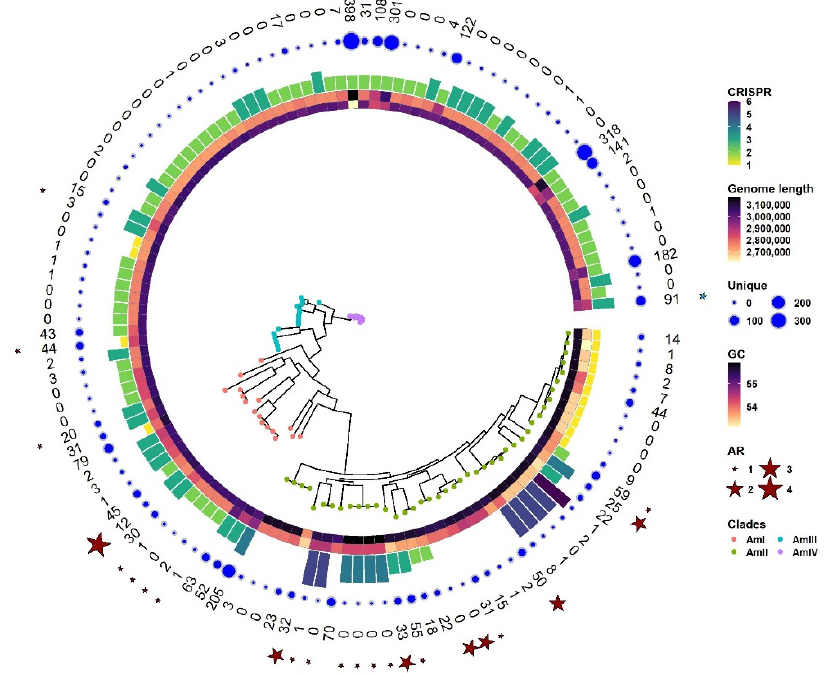
Figure 7. Phylogenetic tree of A. muciniphila strains. Information around the tree provides an overview of the genetic potential of different strains predicted using suitable tools. Strains from different phylogroups are colored differently. The clustering of the strains in the phylogenetic tree corresponds to the clustering inferred in Section 3.4. Layers around the tree denote (from inside out) GC content, genome length, number of CRISPR sequences, number of unique genes as a bubble, number of unique genes in digits, antibiotic resistance genes, and virulent factors. Antibiotic resistance genes are shown by red stars while virulent factors are shown by green stars.